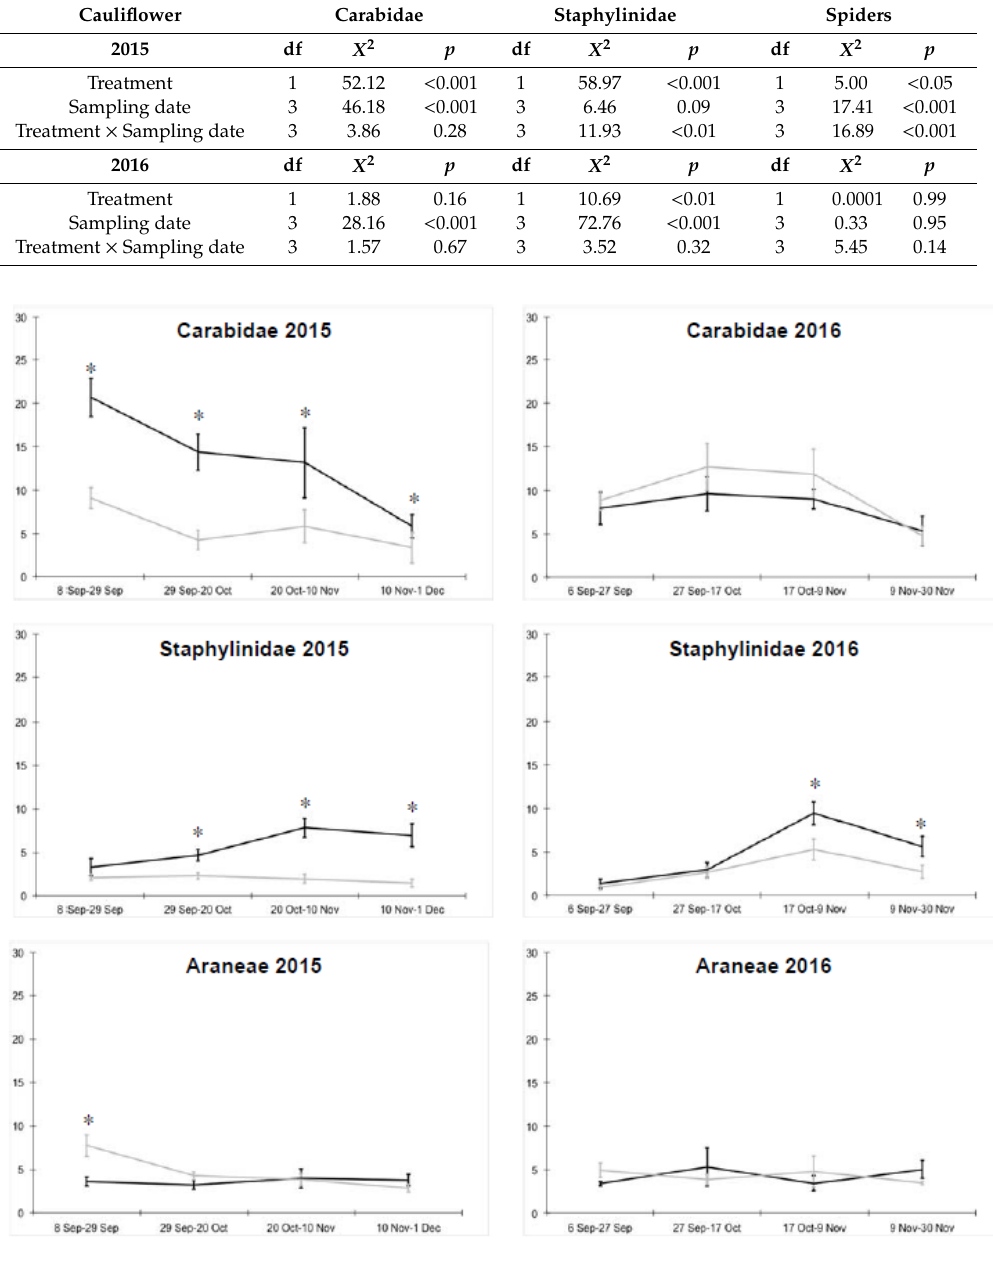
Figure 1. Abundance of individual Carabidae, Staphylinidae and Araneae collected in the experimental plots of cauliflower, where the cover crops were terminated either with a roller crimper (IL-RC, black line) or through green manuring (GM, grey line). Vertical bars represent standard errors of the means; * = significant differences within each sampling date as detected by the generalized linear mixed model.